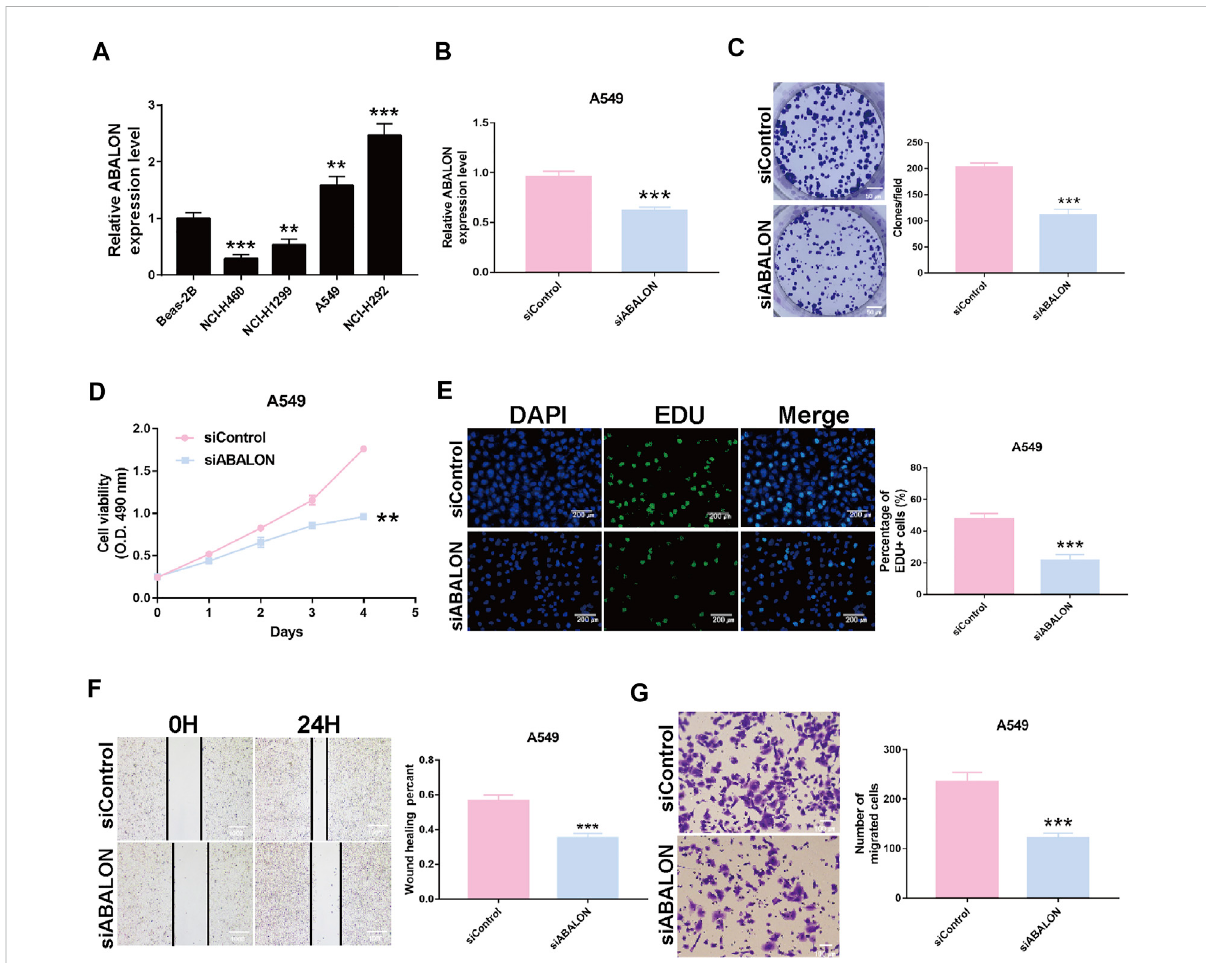
FIGURE 6 DownregulationofABALONsuppressedtheproliferationandmetastasisinA549cells. (A) TheexpressionofABALONincorrespondingcelllines identi fi ed by RT-qPCR. (B) RT-qPCR for the expression of ABALON in siControl and siABALON A549 cells. (C – E) Colony formation (C) , MTT (D) , and EDU (E) assaysidenti fi edproliferationwassuppressed. (F,G) Cellmetastasissuppressionwasidenti fi edbywoundhealing (F) ,andtranswell (G) assays. ** p < 0.01, *** p <